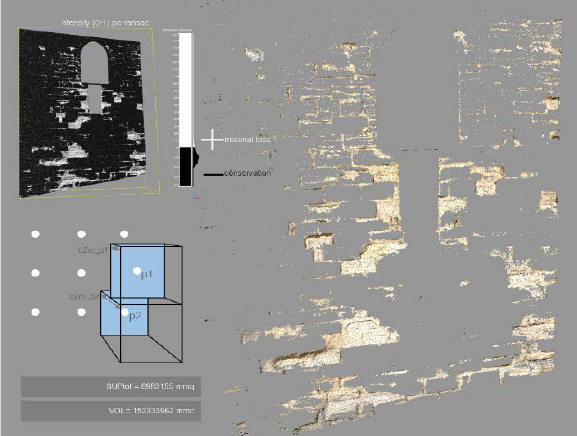
Figure 21. Surface area and volume calculation of the segmented point cloud with positive distance from RANSAC plane.